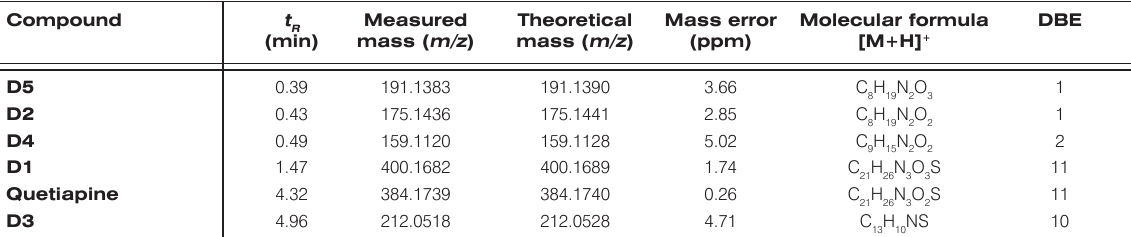
Table 1. Exact mass measurements and elemental composition of quetiapine and its photodegradation products (D1-D5) using Q-TOF MS method.